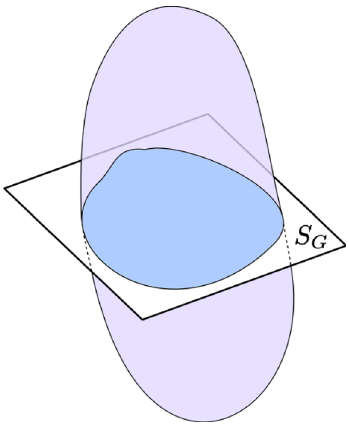
Figure 4 . The subspace S G does not completely contain the Haar’ed Hamiltonian ensemble e E H , represented by a purple blob. The intersection S G ∩ e E H is in